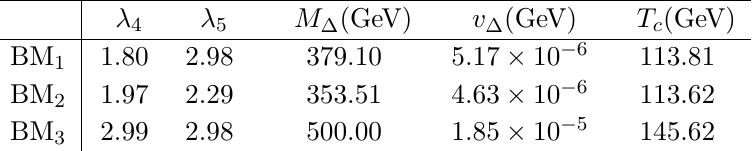
Table 1 . Three benchmark points for illustrating the evolution of the effective